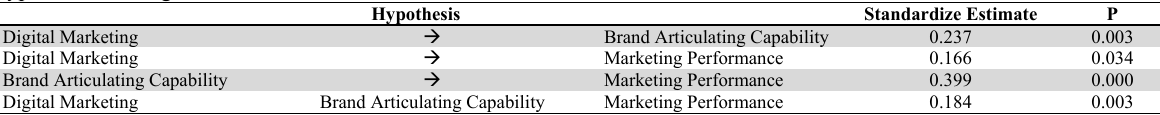
Hypothesis Testing